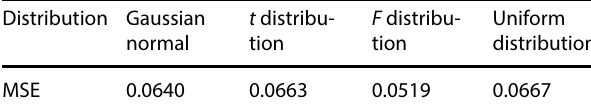
Table 3 Filling results of data with different distributions Distribution Gaussian